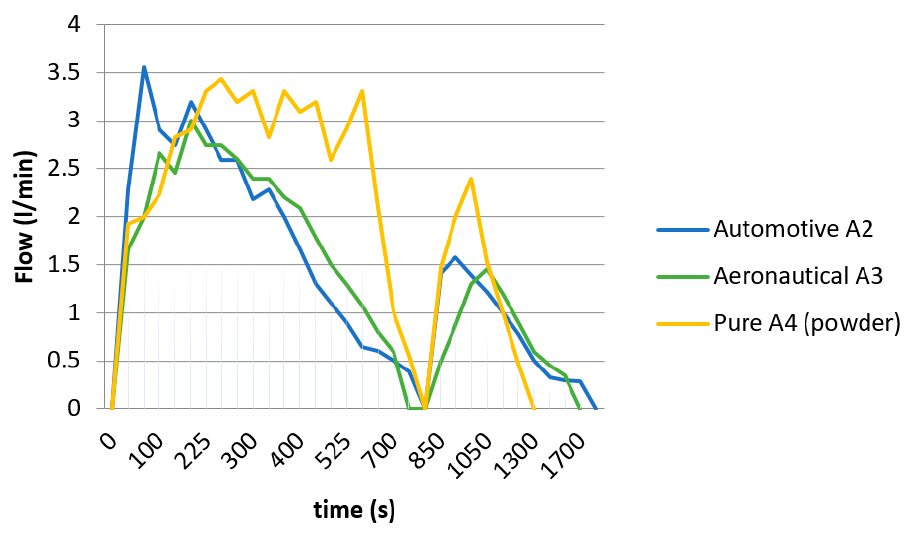
Figure 8. Comparison of the hydrogen flow generated by automotive aluminum chips A2 and aeronautical aluminum chips A3 in alcoholic medium, and isopropyl alcohol, starting from 30 g of aluminum and dosing 10 mL/min of 7.5 M sodium hydroxide solution, at a bath temperature of 60 °C in the reactor. These are compared to the pure granulated aluminum A4 (powder), used as a reference, under the same conditions.